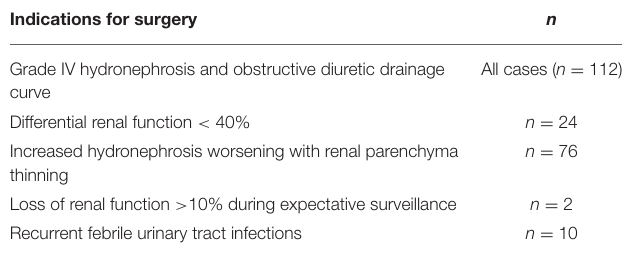
TABLE 1 | Indications for surgery.